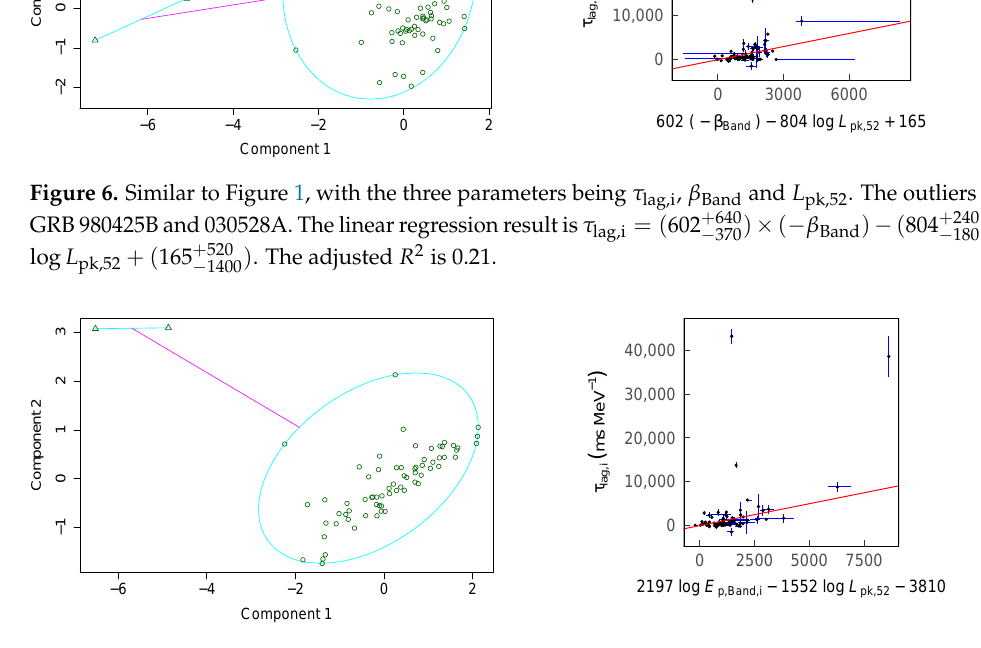
Figure 7. Similar to Figure 1, with the three parameters being τ lag,i , E p,Band,i and L pk,52 . The outliers are GRB 980425B and 030528A. The linear regression result is τ lag,i = ( 2197 + 410 −